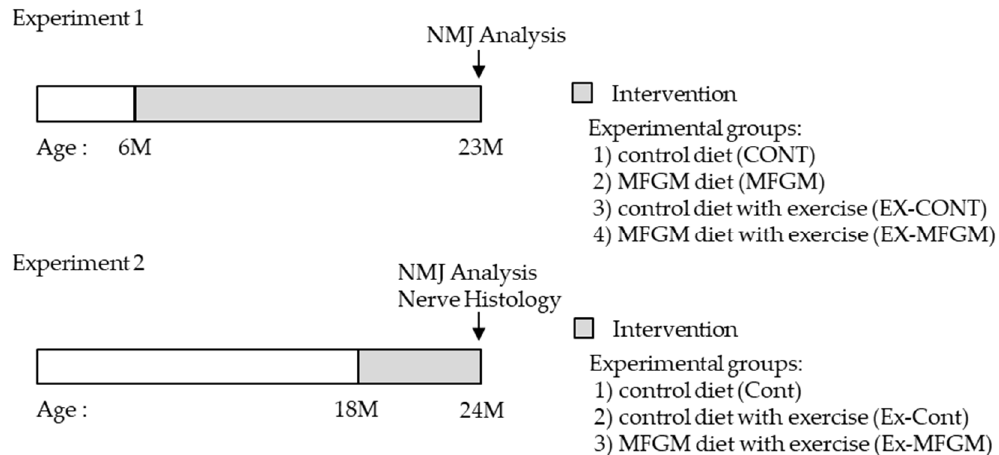
Figure 1. Timelines of the two experiments. MFGM, milk fat globule membrane; NMJ: neuromuscular junction.